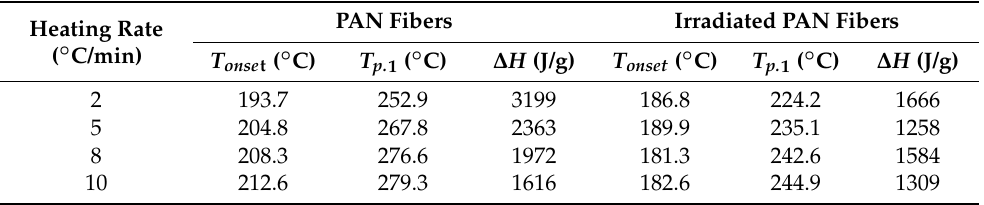
Table 1. Characterization of DSC curves of PAN and irradiated PAN fibers at various heating rates. T onset : onset temperature of exothermic reaction; T p. 1 : first exothermic peak temperature; Δ H : enthalpy change.